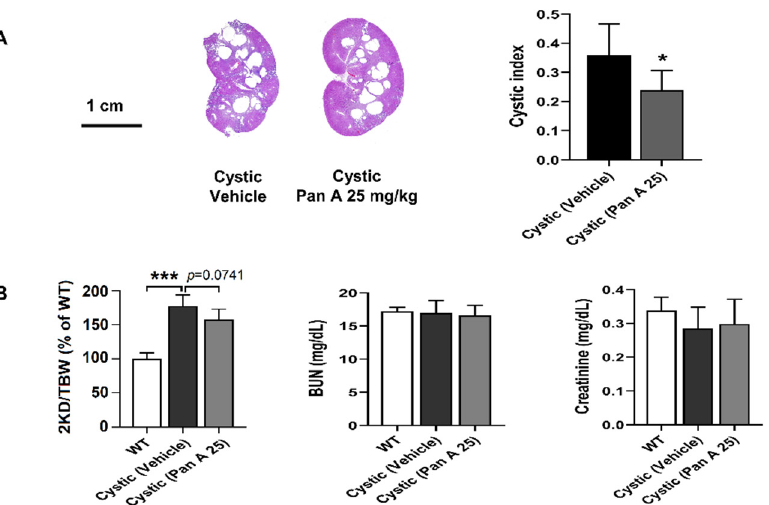
Figure 6. Effect of panduratin A on renal cyst progression in ARPKD rats. ( A ) H&E staining of histological kidney sections and cystic index from PCK rats treated with vehicle and panduratin A (Pan A) 25 mg/kg BW. ( B ) Percentage kidney weight to total body weight (2KD/TBW) and parameter assessment of renal function in wild-type (WT) and cystic (PCK) rats. Data are shown as mean ± SD, n = 4 and 6 per group for WT and PCK rats, respectively, * p < 0.05 and *** p < 0.001.